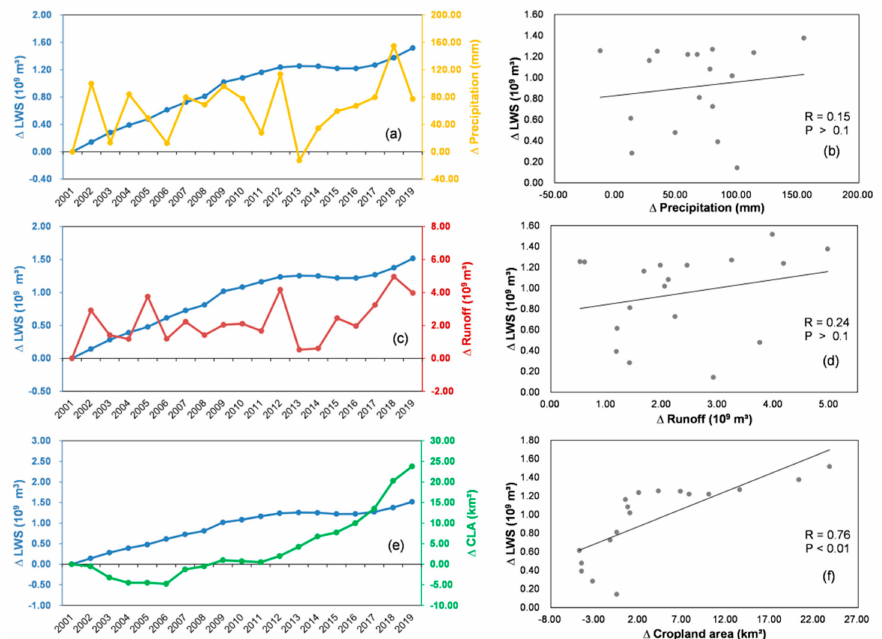
Figure 19. The left column shows variations in water storage plotted along with ( a ) variation in precipitation, ( c ) variation in runoff volume, and ( e ) variation in cropland cover relative to 2001. The right column shows the water storage as a function of ( b ) variation in precipitation, ( d ) runoff volume, and ( f ) cropland area relative to